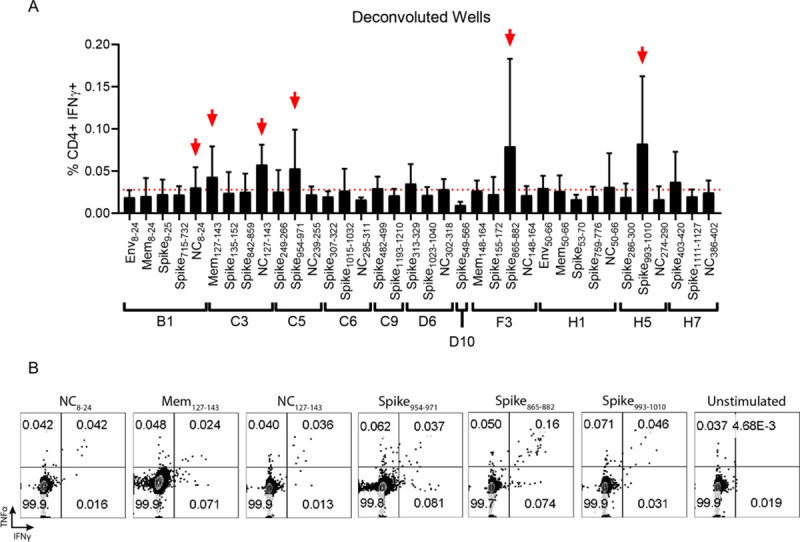
In vivo transfection of hACE2 mRNA permits the detection and functional mapping of SARS-CoV-2 specific CD4+ T cell responses.(A) As potential “well” hits were identified, the peptides contained in each well were deconvoluted and used individually to stimulate splenocytes from hACE2 transfected, SARS-CoV-2 infected mice. 6 potential epitopes were identified (marked with red arrows) as defined by the frequency of IFN-γ+ CD4+ T cells being at least 2-fold above background (stimulated with vehicle) in at least 3 of the 4 mice screened. (B) Representative flow cytometry plots displaying IFN-γ and TNFα expression in CD4+ T cells for each putative epitope in comparison to a vehicle control.